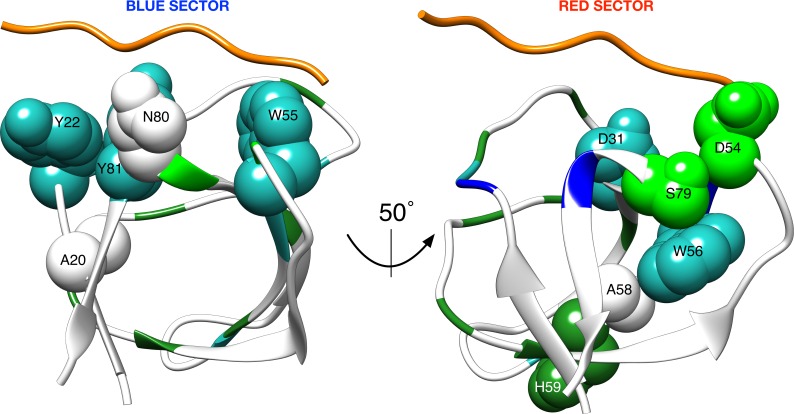
Mapping between the SH3 evolutionary sectors identified in [15] and the consensus predictions.The residues belonging to the two sectors identified in [15] are mapped on the reference structure of Src SH3 (used also in Figs 1A and 7). They are colored in the same way as Fig 6 except for N80, which is not part of the top-ranked residues in the consensus models, and the alanine residues, which cannot be predicted by the MCIT approach. The two orientations of the structure match those reported in figure 7 of [15] to allow for comparison. Residues are labeled following the SA numbering to facilitate comparison with Fig 6.